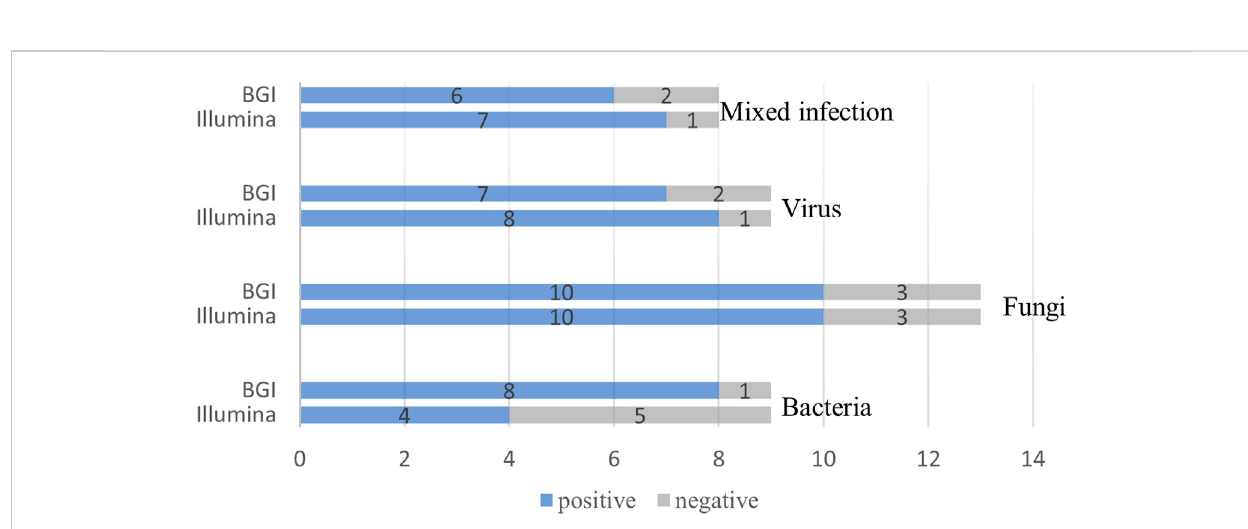
FIGURE 5 Comparison of the Illumina and BGI platforms in detecting different pathogens. No signi fi cant difference was observed between the two platforms ( p > 0.05). The number of positive samples ( x -axis) for pairwise Illumina and BGI platforms is plotted against the bacteria, fungi, virus and mixed infection groups ( y